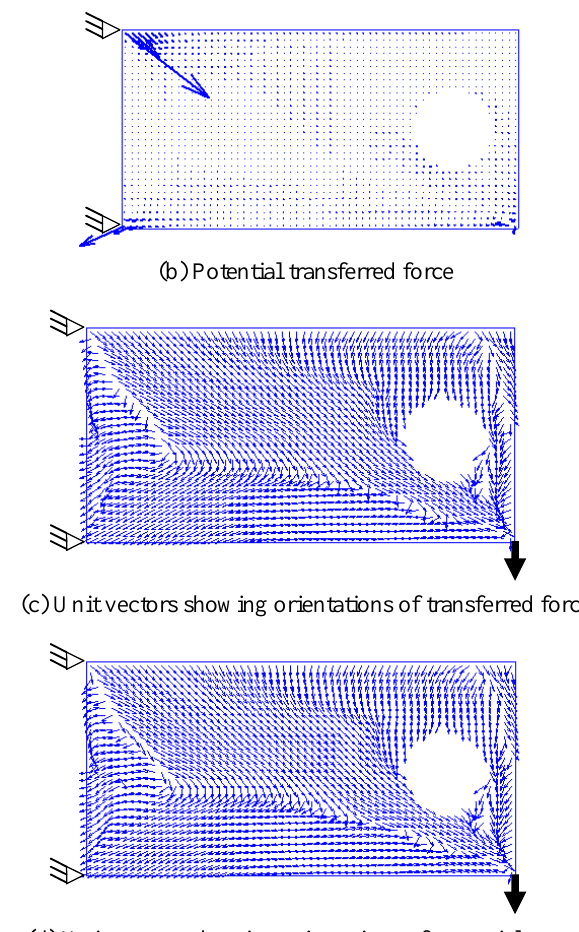
Fig. 24. Load paths based on U * for rectangular